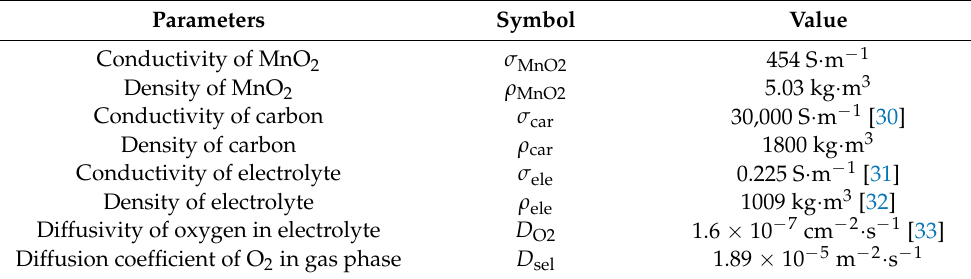
Figure 4. Different electrodes with electrolyte filling degrees of ( a ) 0%, ( b ) 20%, ( c ) 40%, ( d ) 60%, ( e ) 80%, and ( f ) 100%. Table 1. Parameters of catalysts, electrolytes, and electrodes used in this